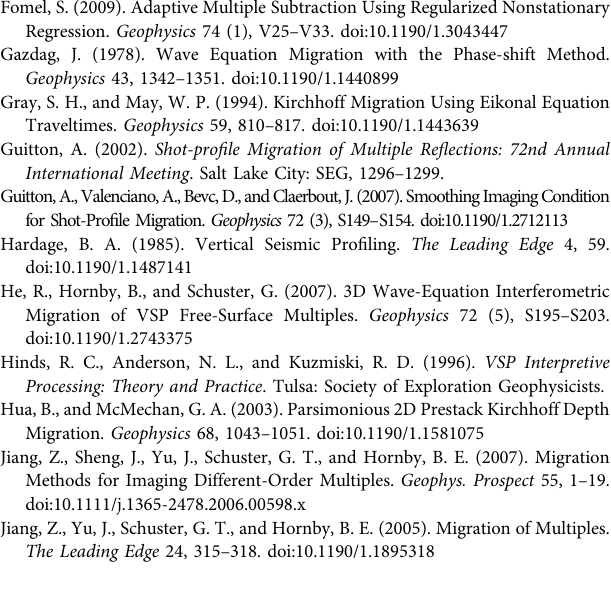
algorithm handles free-surface related multiples without the need of multiple prediction in preprocessing. The method has